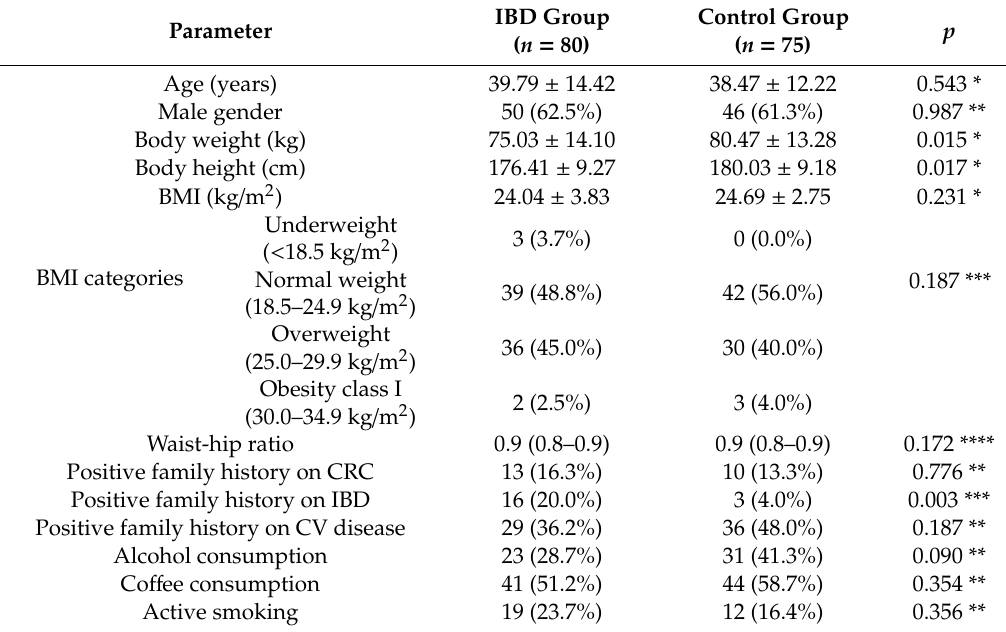
Table 1. Basic characteristics of IBD and control